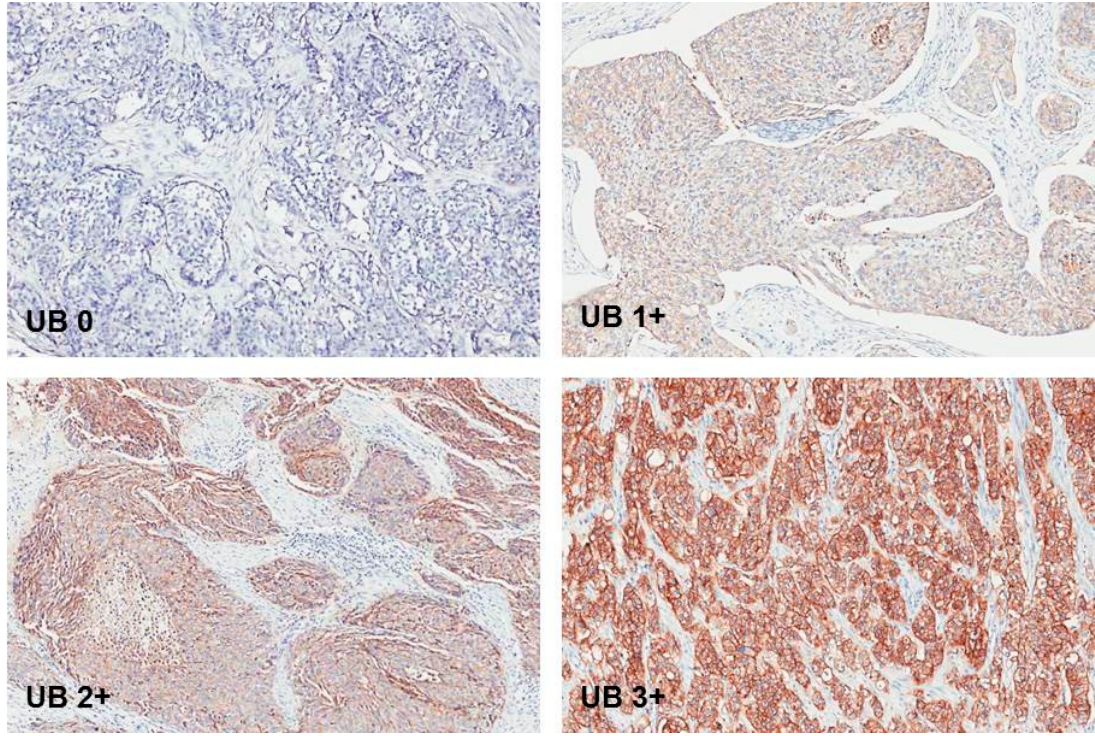
Figure 3. Primary tumor in urinary bladder without EpCAM expression and with EpCAM expression with intensity score 1 : weak; 2 : moderate; and 3 : strong. Original magnification: 200 × .